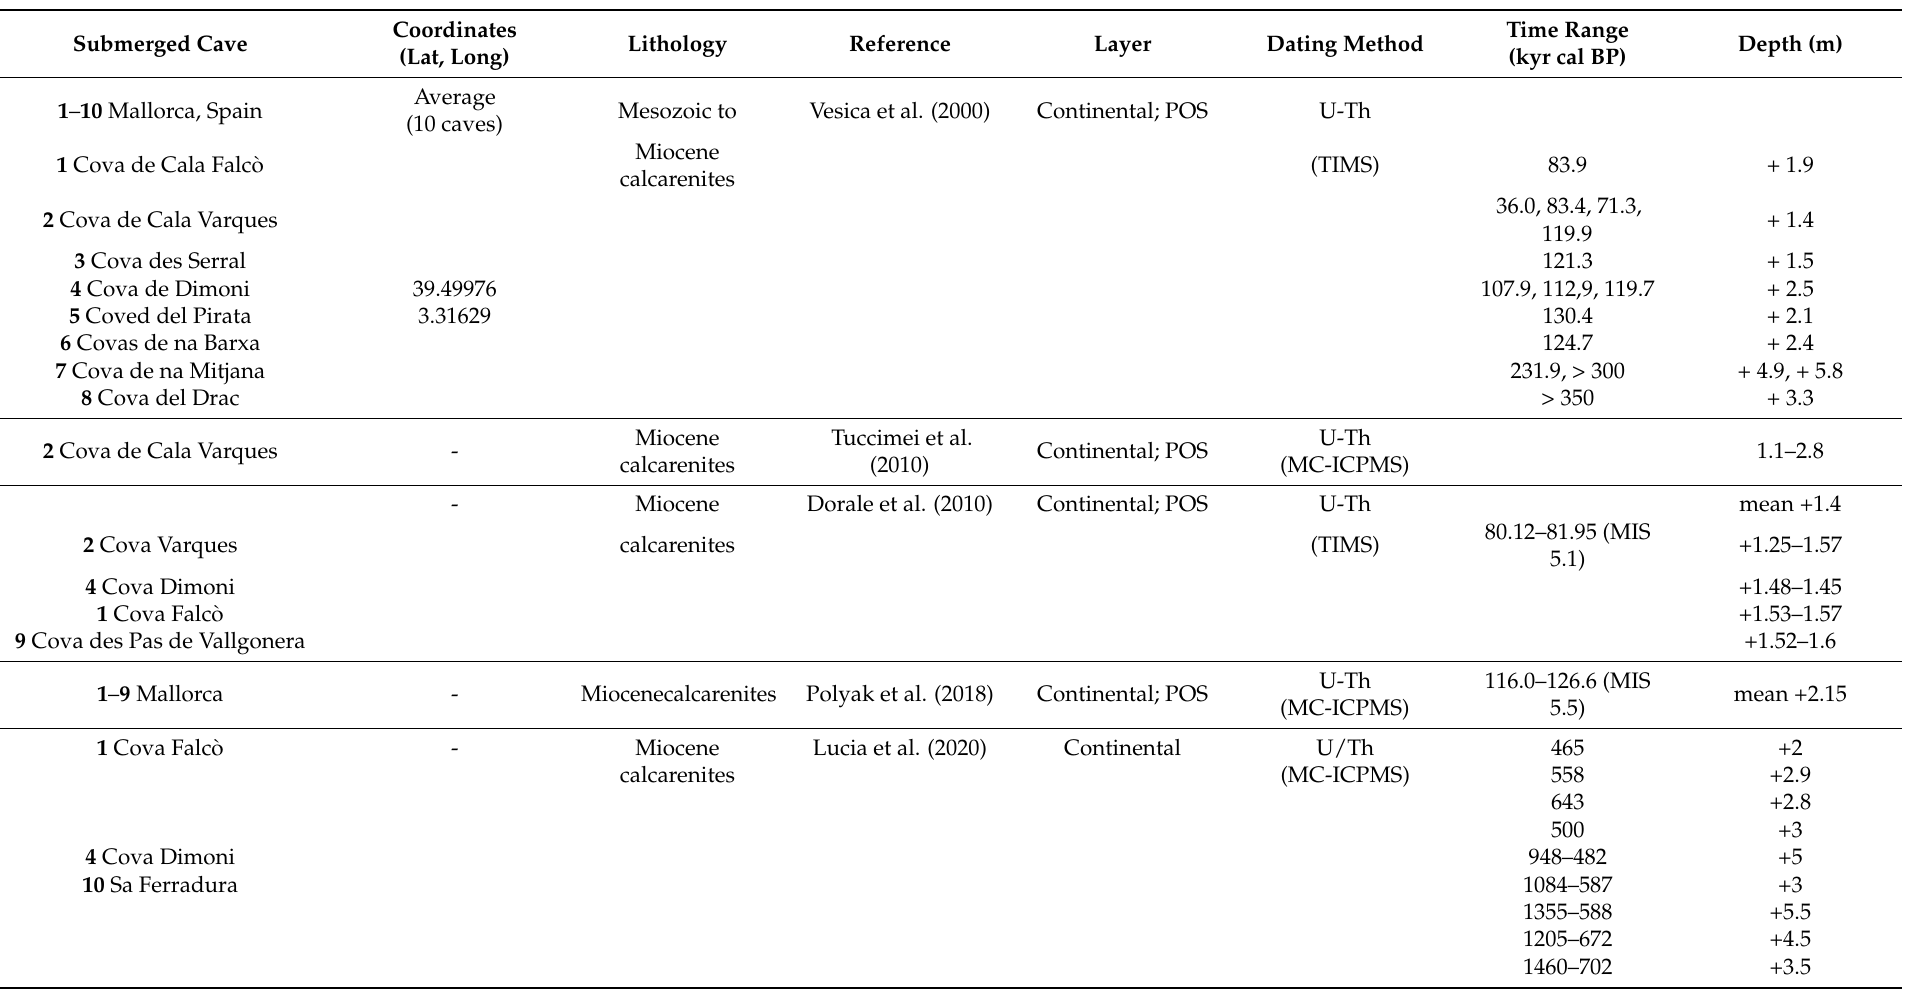
Table 3. Locations and geographic coordinates of the caves and speleothems reported in this study, with information on the speleothem layer(s) analysed, dating method, and time range. POS: phreatic overgrowth on the speleothem; MOVR: marine overgrowth; LB: Lithophaga bores; and MIS: Marine Isotope Stage. For further details on the ages of samples collected from locations 27–33, refer to Table